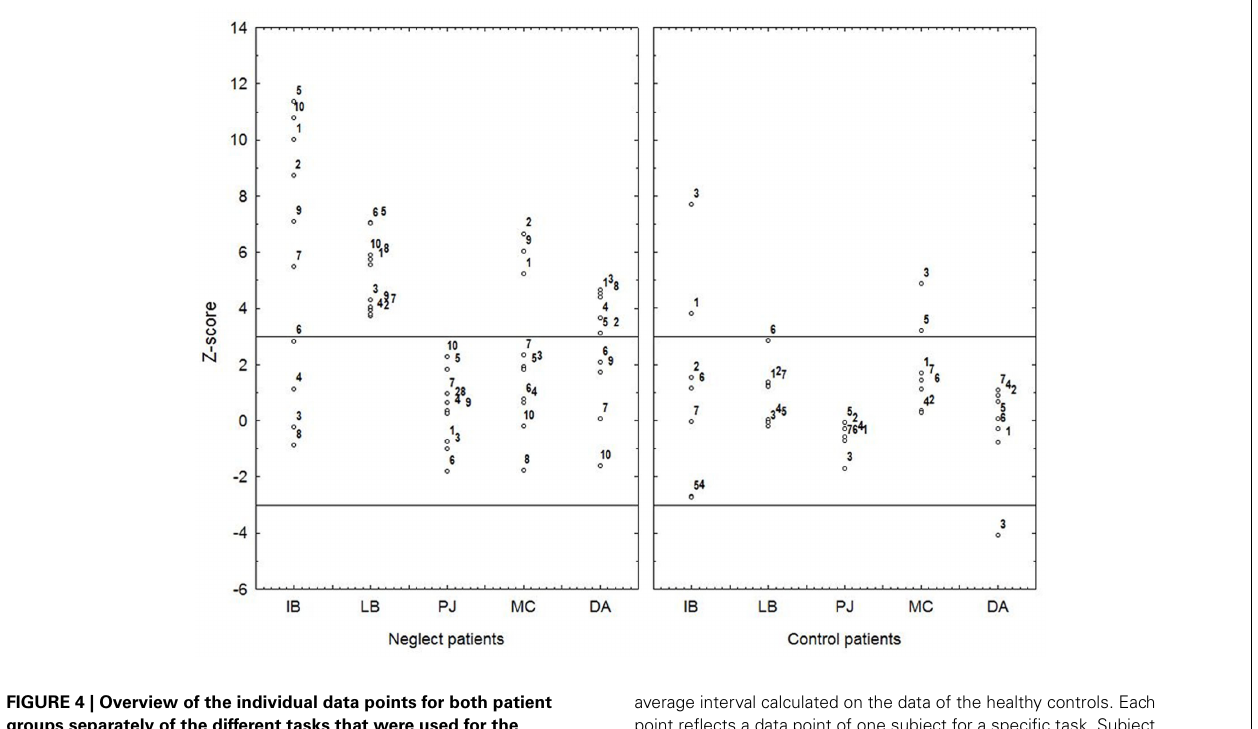
FIGURE 4 | Overview of the individual data points for both patient groups separately of the different tasks that were used for the PCA. Each data-point reflects the z -score values based on the average and SD of the healthy controls, and the directionality of the dependent variables was adjusted so that a larger positive number always indicates a larger effect.The black lines indicate the ± 3 SD from the